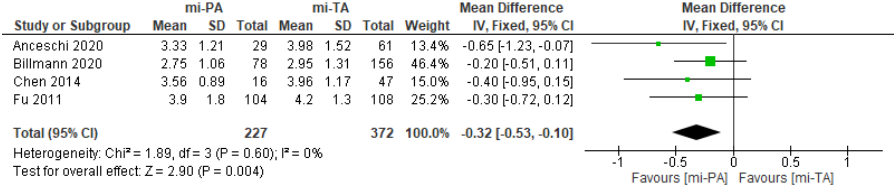
J. Clin. Med. 2022 , 11 , 1263 10 of 17 ( d ) Forest plot representing analysis of mean hospital stay.